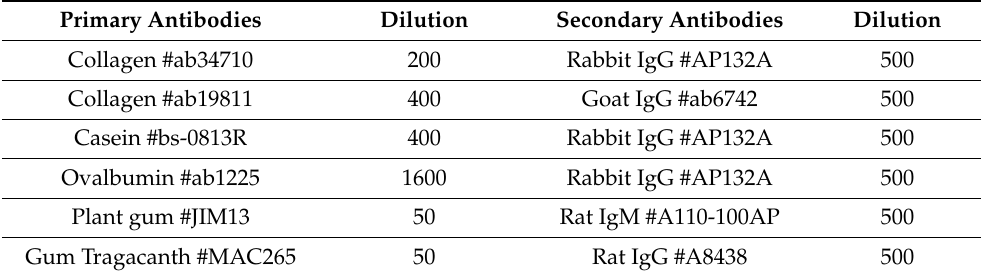
Table 2. Antibodies for ELISA at the National Museum of Western Art, Japan (as of 2018). Primary Antibodies Dilution Secondary Antibodies Dilution Collagen #ab34710 200 Rabbit IgG #AP132A